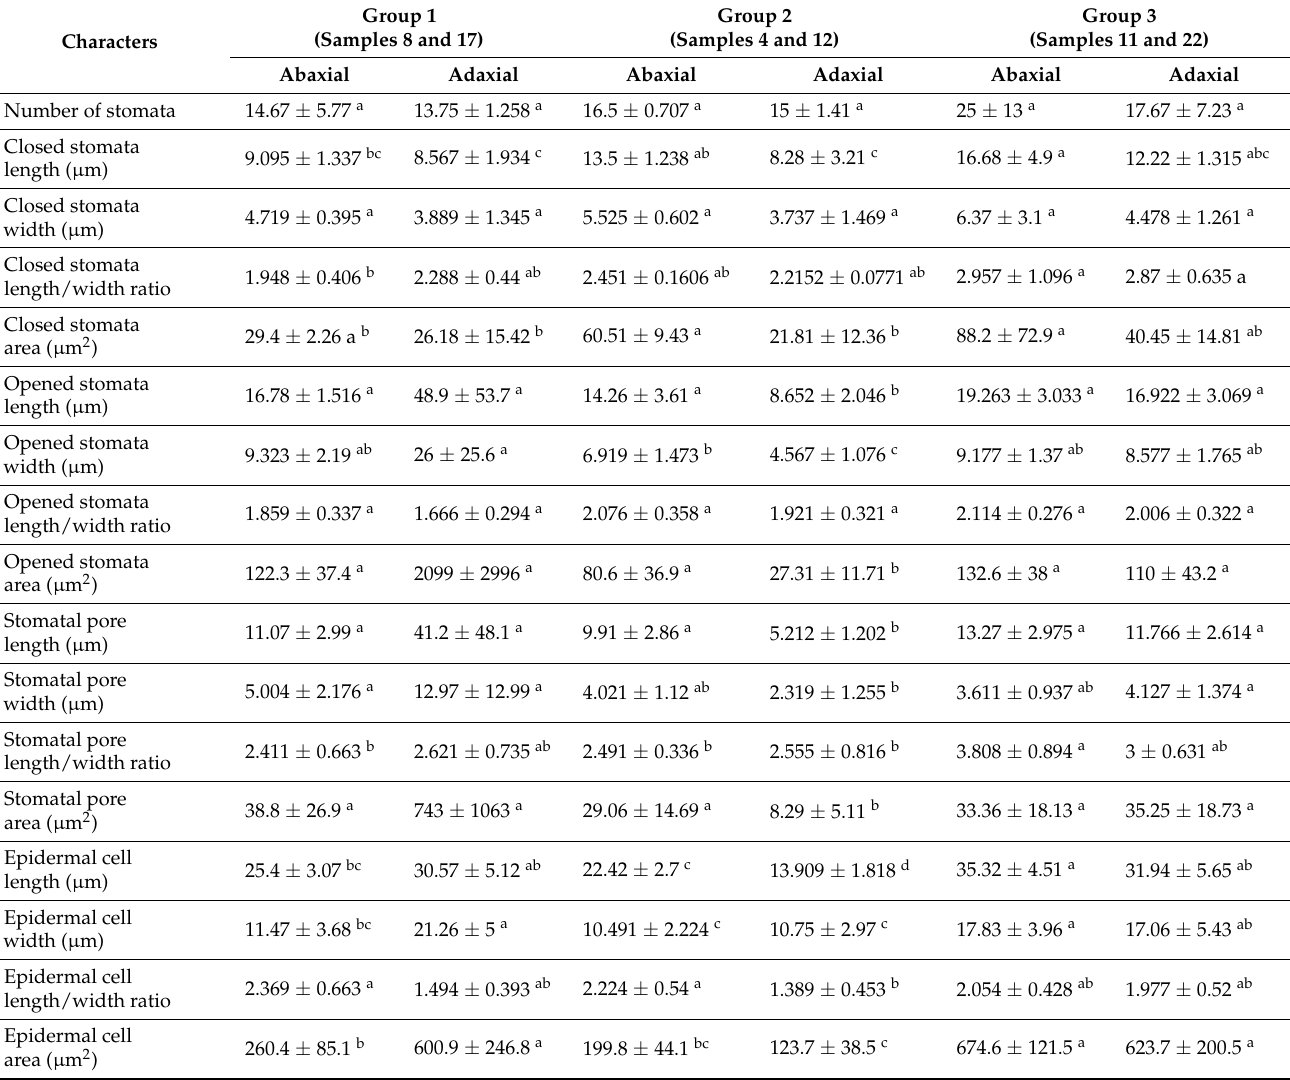
Table 5. Two-way ANOVA analysis of Ricinus communis abaxial and adaxial leaf ultrastructure traits. Different letters represent significant